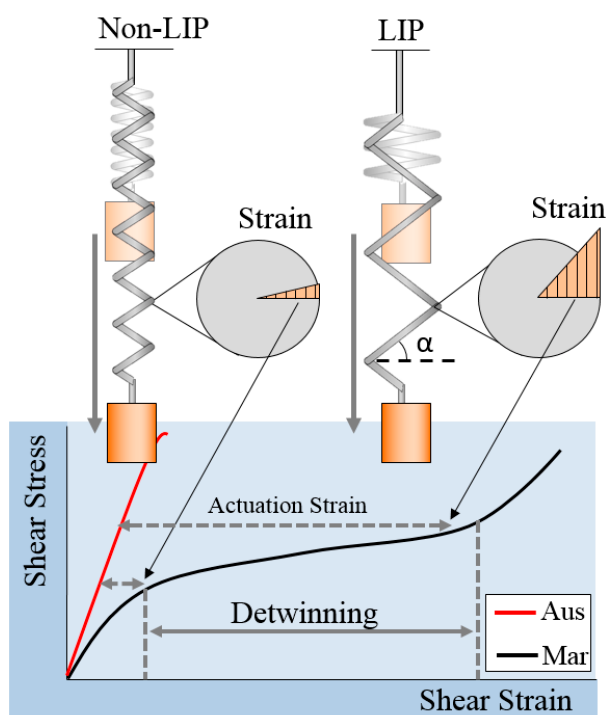
Figure 1. Comparison between large index and pitch angle (LIP) design and non-LIP design of shape memory alloy (SMA) coil spring actuators. The LIP design has a large pitch angle ( α ) and shear strain that can use the detwinning region of the SMAs. The large coil diameter improves the cooling performance for high-frequency actuation. The graph shows the representative shear stress–shear strain relationship in Austenite phase (Aus) and Martensite phase